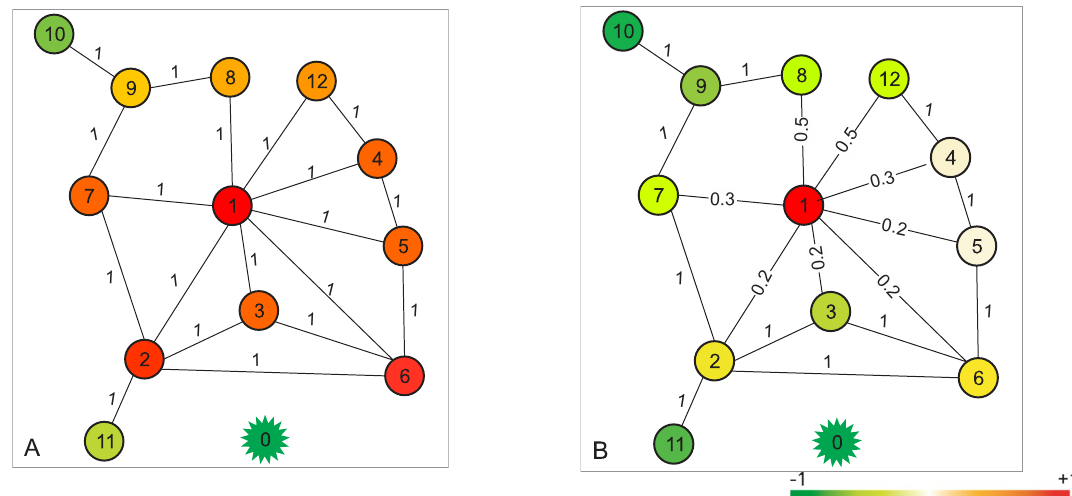
Figure 2. An illustrative example of how network structure influences the competitive impact results between driver gene and drug. A disease network with 12 genes and 19 interactions is given. Node 1 (red) is a driver gene whose state is fixed by 1. Node 0 (green) is a drug whose state is fixed by −1. An undirected interaction is temporarily added between the drug and each normal gene for computing support of the normal gene to the driver gene against impact from the drug. The state of each gene converges to a steady value which is a convex combination of the competitors’ states, and does not depend on the initial states of genes. The color gradient represents support bias to two competitors. ( A ) The weights are kept at the default value of 1 for all links. The result shows that most genes in the network impacted by the driver gene, except 10 and 11 ( B ) A handful of links are changed in weight. Interestingly, there are large fluctuations in the network. Most genes in the network turn to impacted by the